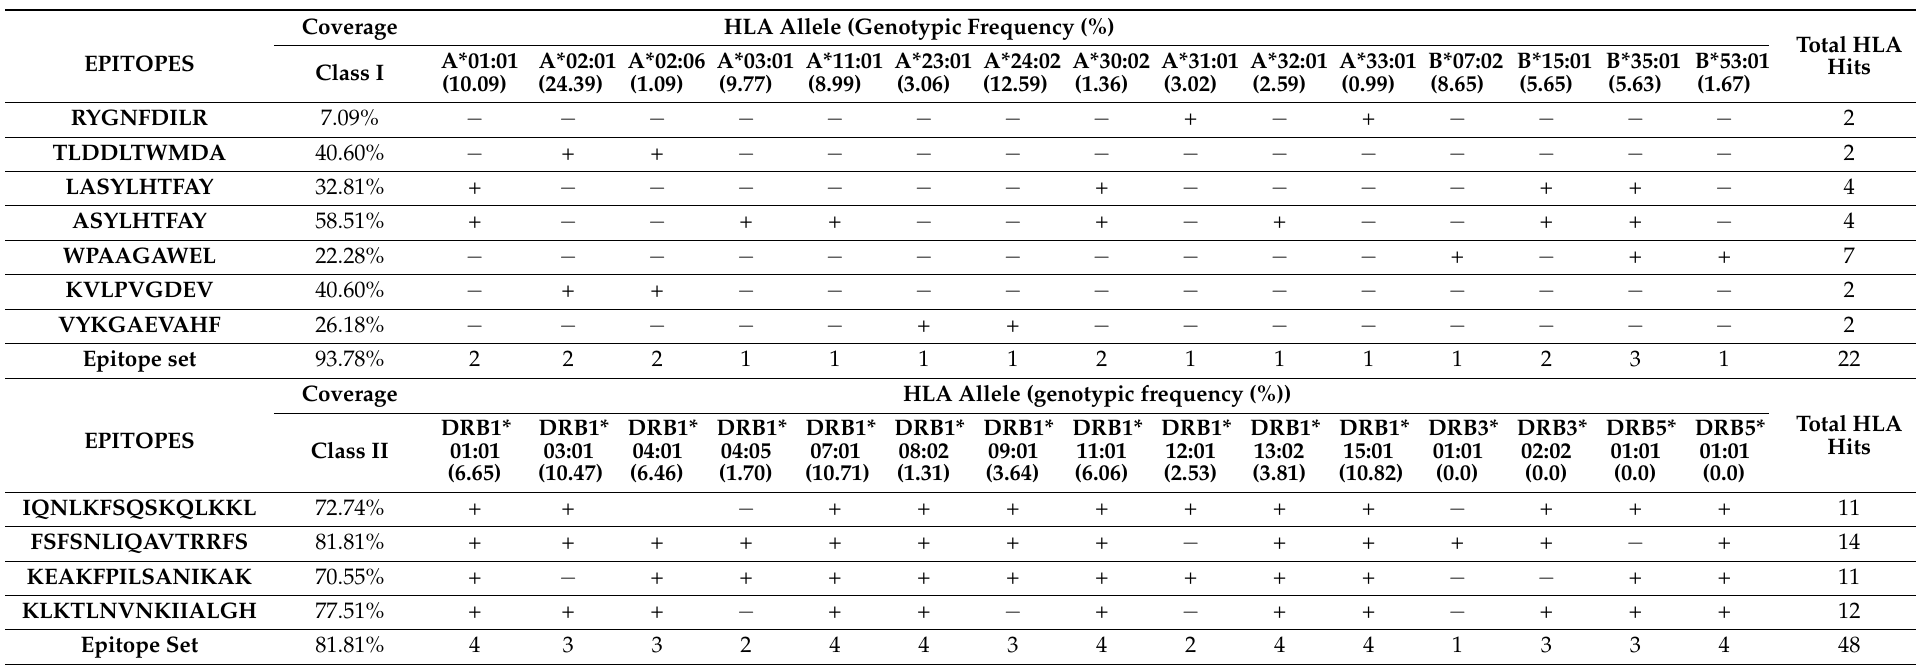
Table 3. World population coverage of individual CTL and HTL epitopes (MHC class-I and MHC class-II).